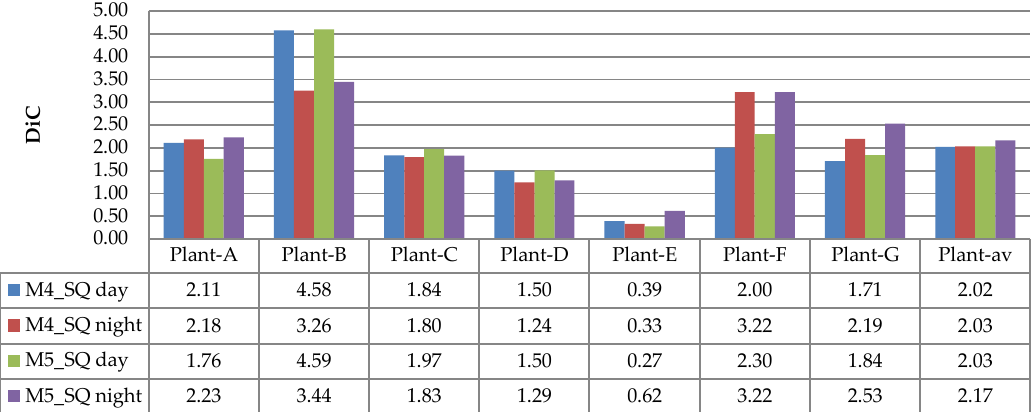
Figure 20. Results of DiC measurements using the NoIR camera.